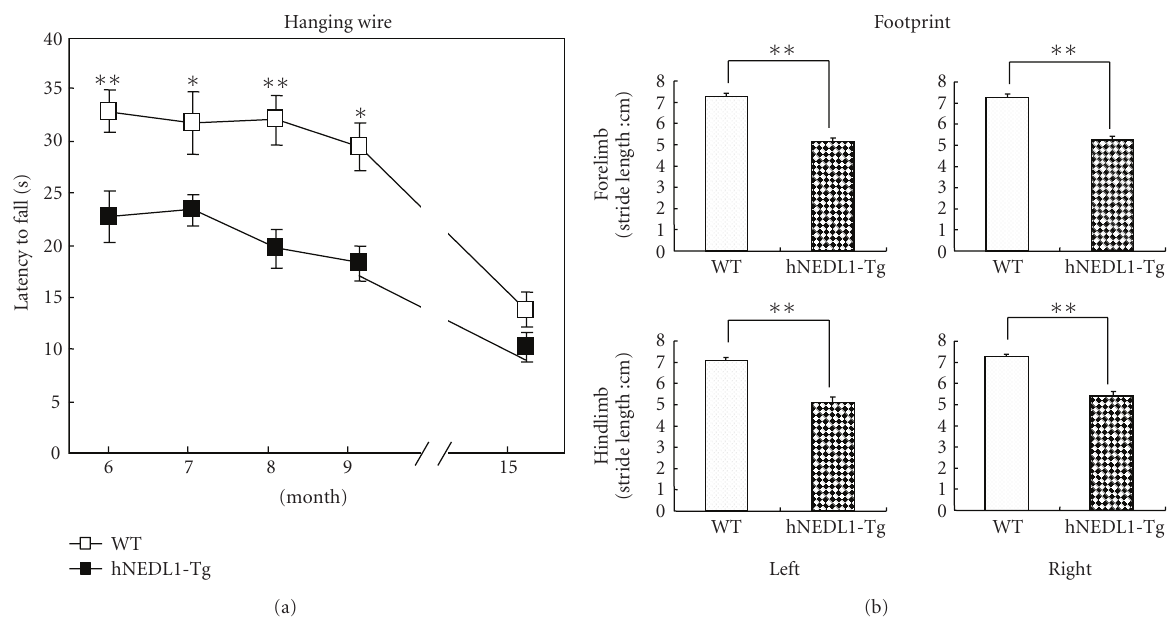
Figure 3: Overexpression of hNEDL1 a ff ected the hanging wire and foot print performances. (a) The hanging wire performance of wild-type (white bar: n = 12) and hNEDL1-Tg mice (black bar: n = 11) from the age of six to fifteen months. Data are mean ± SEM ( ∗ P < . 05; ∗∗ P < . 01). (b) The distance between forepaw/hindpaw placements in each stride was recorded and analyzed in the wild type (white bar: n = 12) and hNEDL1-Tg mice (black bar: n = 11) from the age of six to fifteen months. Data are mean ± SEM ( ∗ P < . 05; ∗∗ P < .